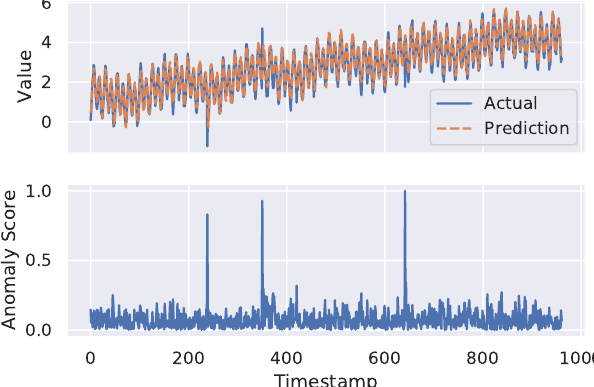
Figure 4. Forecasting and anomaly detection results of FuseAD on the TS11 time-series from the Yahoo A3 sub-benchmark. The upper plot shows the actual time-series and forecasting results on test data, whereas the lower plot shows the anomaly score at each time-stamp. The anomaly label (i.e., 1) is assigned to data points that have a high anomaly